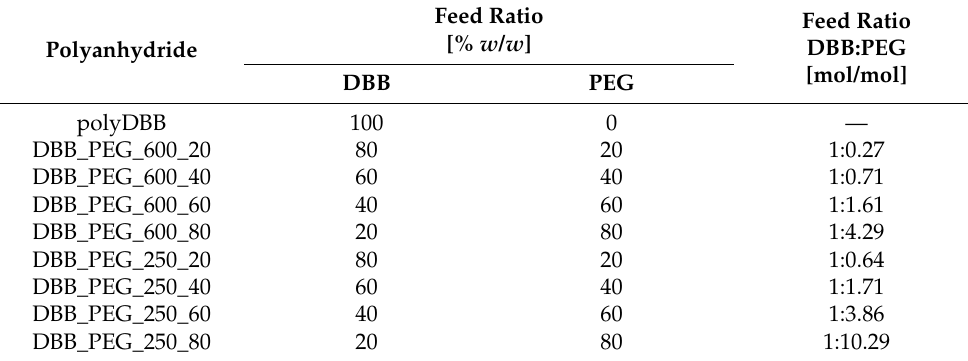
Table 7. Feed ratio of DBB and